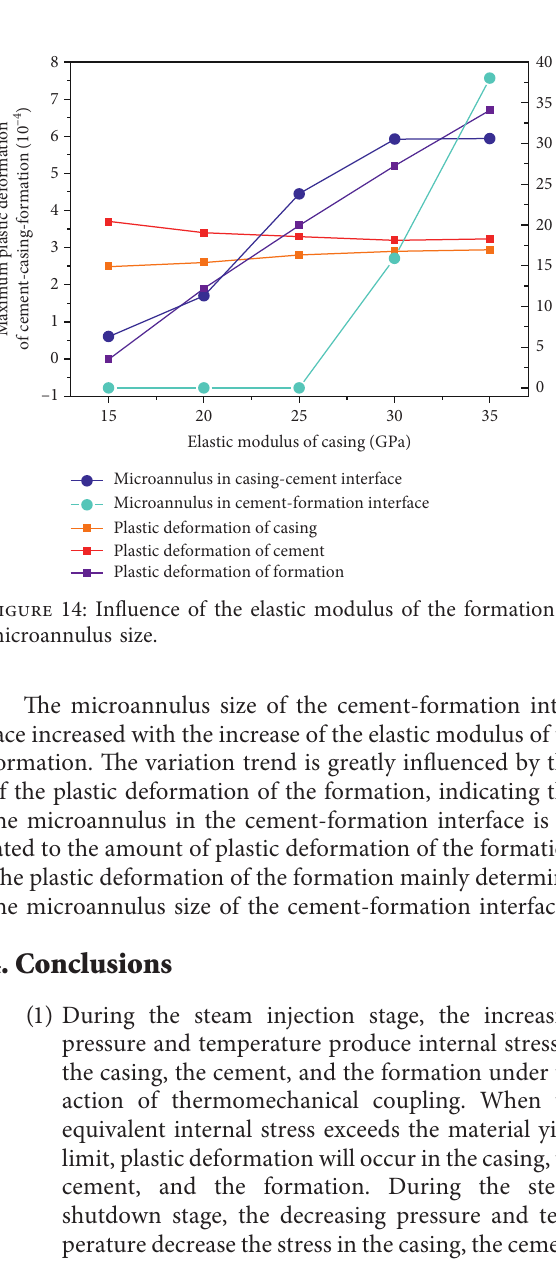
Figure 13: Plastic deformation and microannulus with different formation elastic moduli.